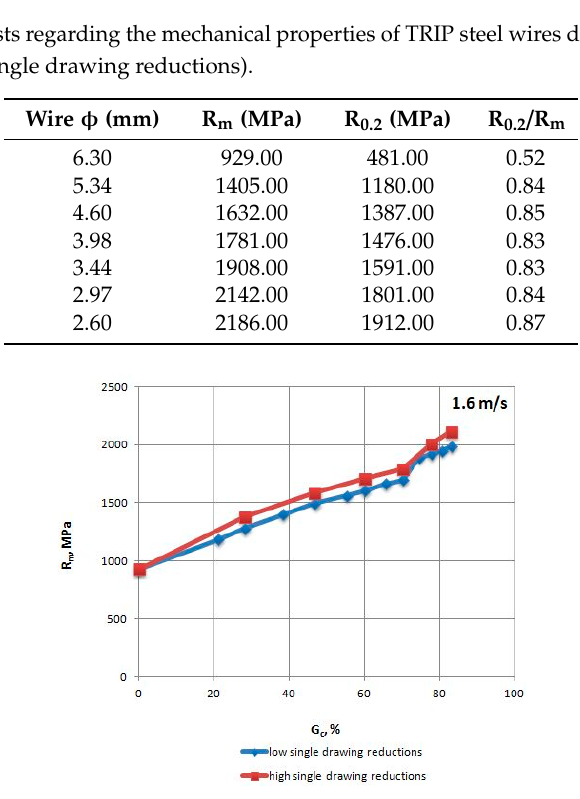
Figure 2. Change in the tensile strength R m of TRIP steel wires for variants with low and high single drawing reductions, at a speed of 1.6 m/s, as the total drawing reduction function.